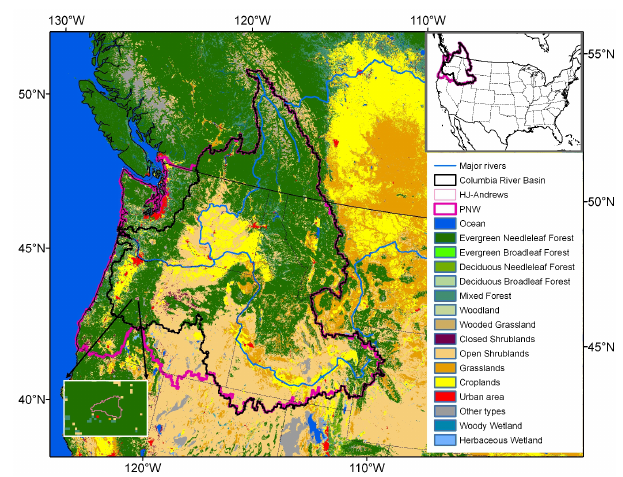
Fig. 1. Study area and simulation domain for this study. Pacific Northwest: VIC, VIC-CropSyst, and MEGAN domains; Columbia River basin: NEWS-DIN domain; HJ-Andrews: RHESSys